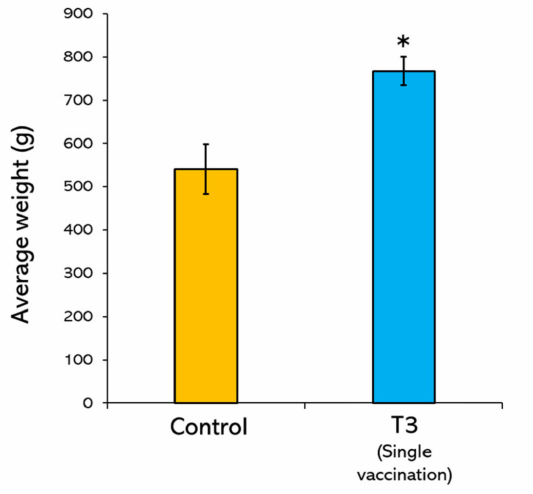
Figure 8. Average weight of Nile tilapia single vaccinated with bivalent vaccine and non-vaccinated (control) in field trial. The fish were cultivated for 6 months in Kanchanaburi province Thailand during October 2021–March 2022. Asterisk (*) indicated the significant difference between vaccinated and non-vaccinated fish ( p <